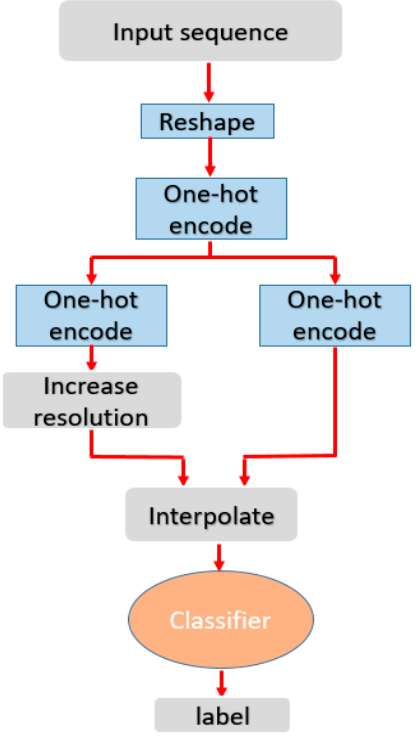
Figure 6. Character recognition pipeline.